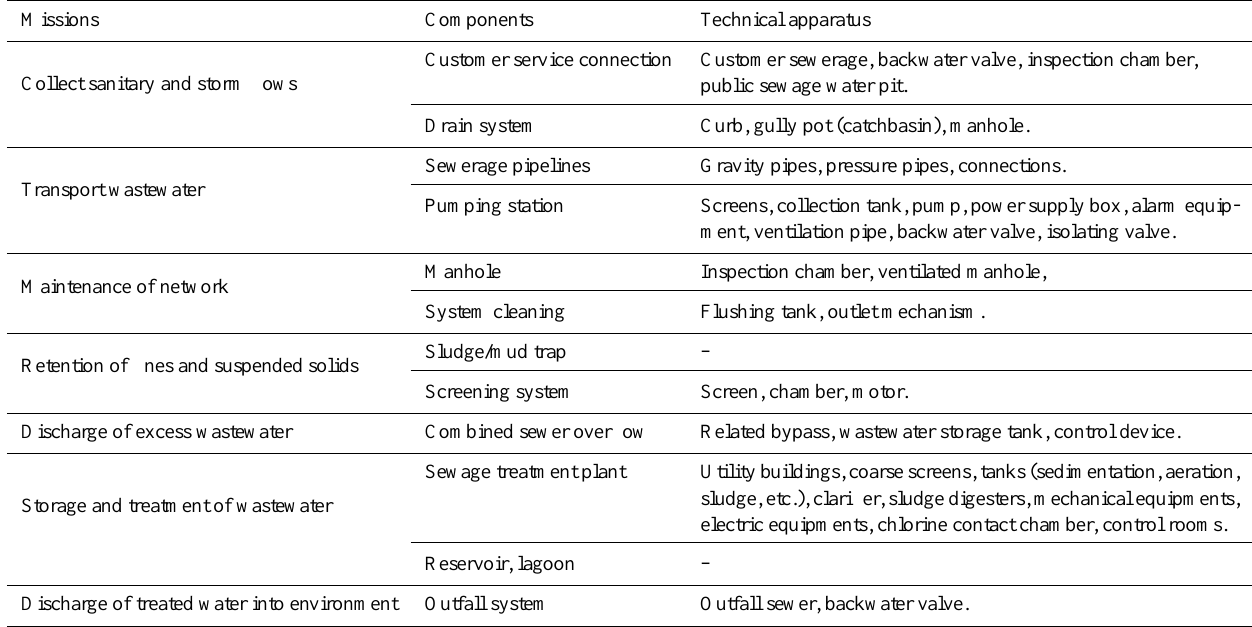
Table 1. Description of the combined sewerage and drainage network distinguishing its missions, components and technical